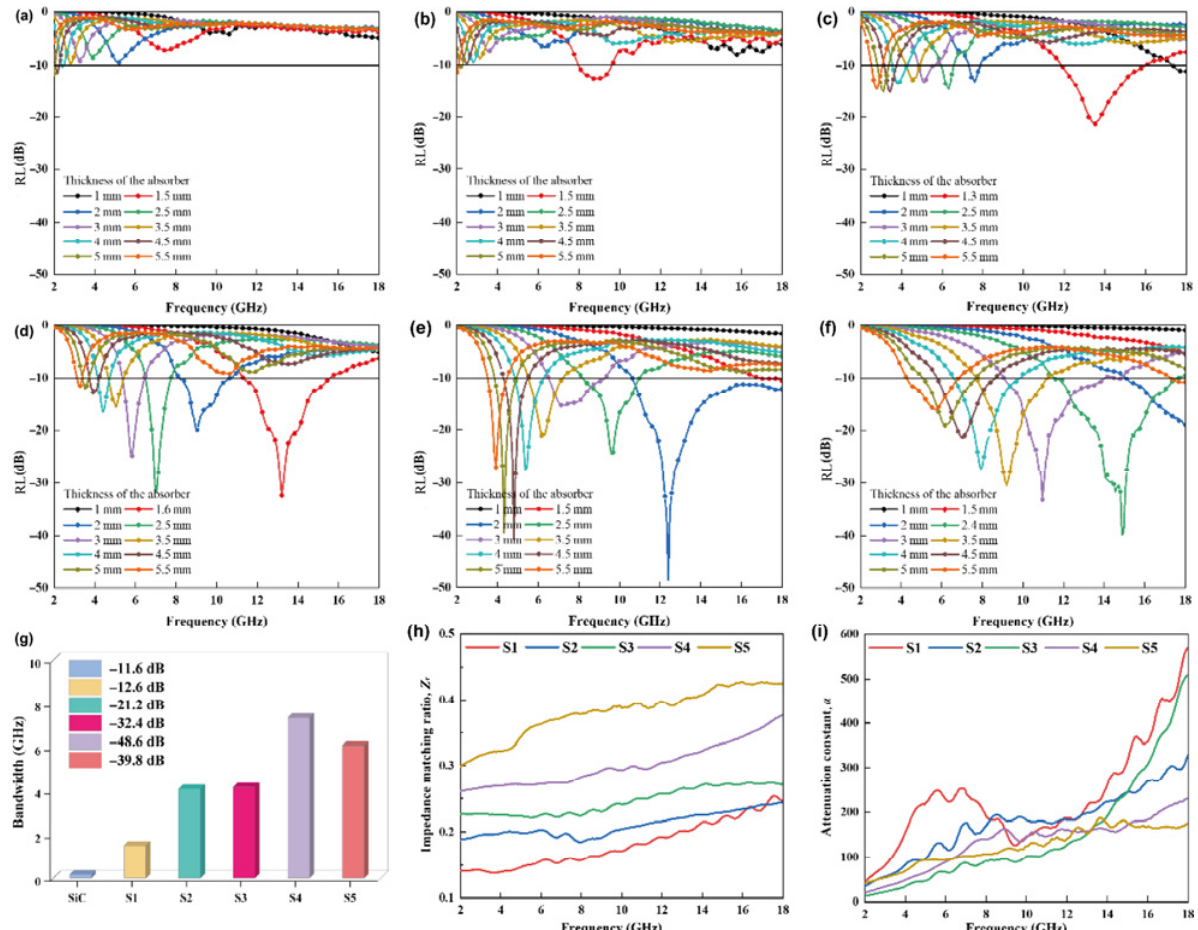
Fig. 5 EM attenuation performance. RL dependence on the frequencies of (a) pure SiC aerogel, (b) S1, (c) S2, (d) S3, (e) S4, and (f) S5. (g) Comparison of RL min and EAB of pure SiC aerogel and S1–S5. (h) Impedance matching ratios Z r and (i) attenuation constants α of